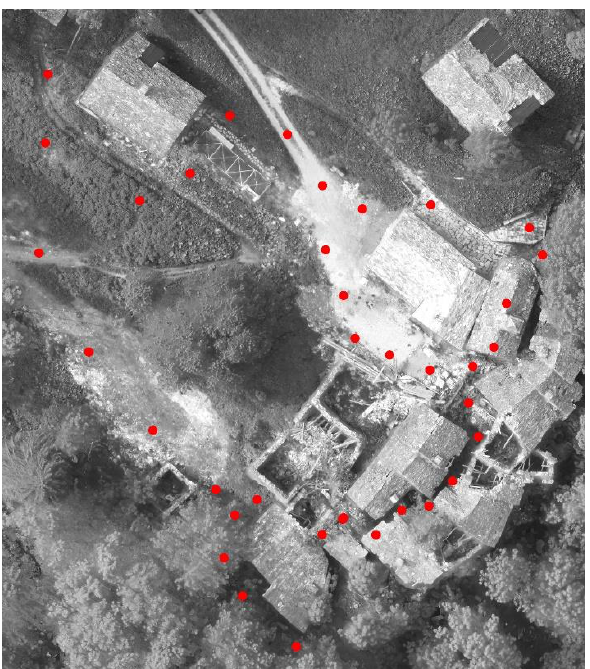
Figure 3. Location of scan positions inside and outside the village.